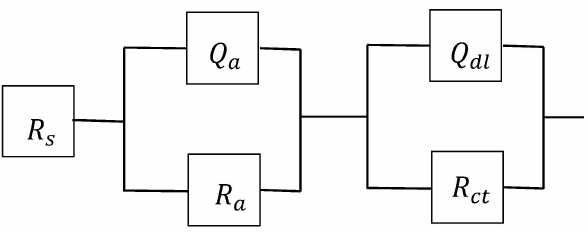
Figure 2. Equivalent circuit for impedance measurements.